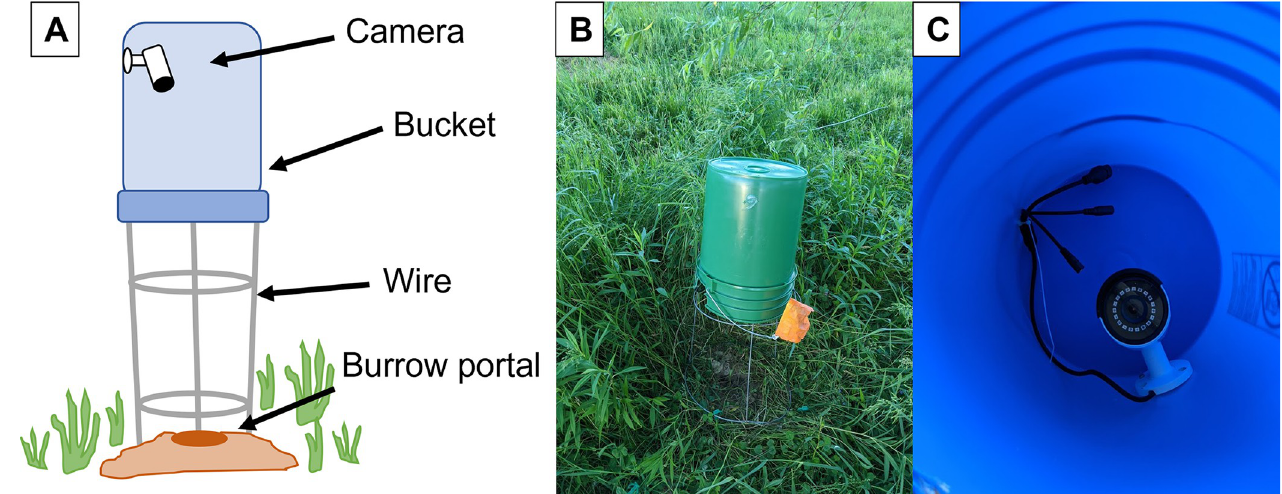
Fig 2. Images representing our custom video surveillance mount. (A) Diagram of our video surveillance setup used to monitor crayfish behavior. (B) Photograph of the setup in situ C) Photograph of the view of the camera mounted from inside of the bucket.